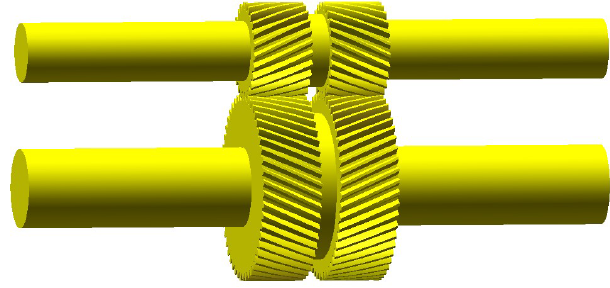
Figure 7. The accurate three-dimensional solid model of the modi- fied double-helical gear